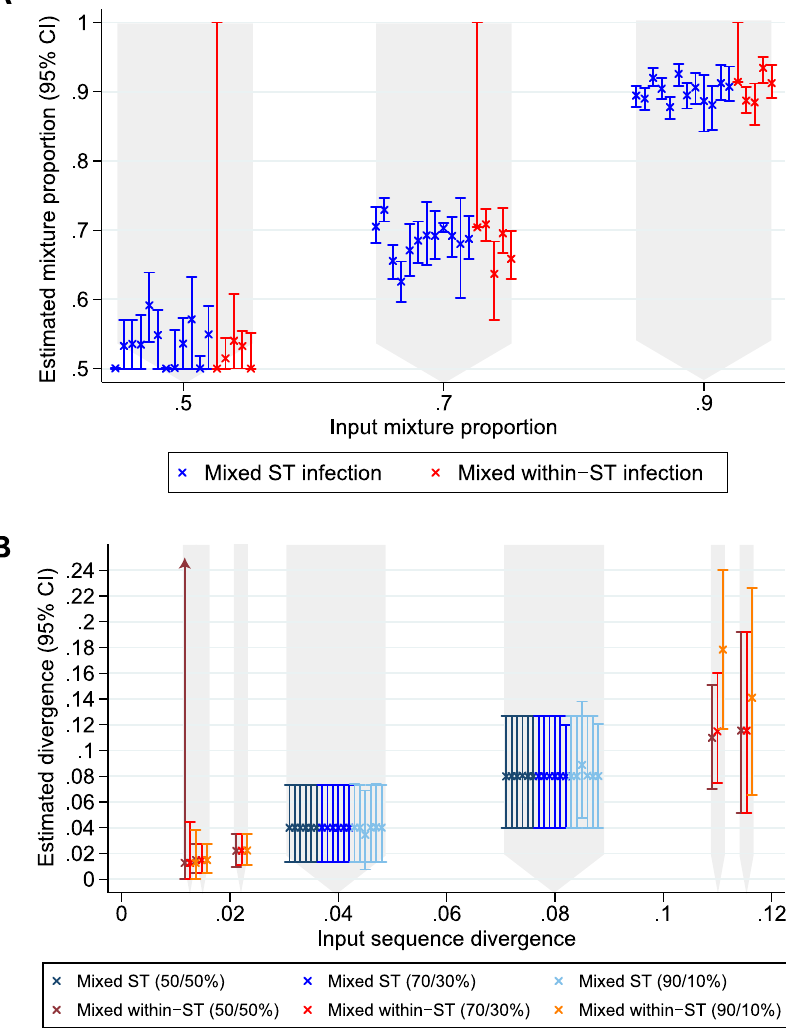
Figure 2. Invitro simulated mixed infections. Panel A shows the estimated mixture proportion for 3 input DNA mixture proportions. For ease of visualisation individual data points have different x-axis values, but correspond to the 3 x-axis values as indicated by the grey background. Points obtained from mixes of two differing STs are shown in red, and points from mixing two isolates of the same ST in blue. The large confidence intervals for the leftmost of each red group of samples is a sample with only a single variant site between the two input sequences, which when excluded in bootstrap sampling makes the sample appear unmixed. Panel B shows the estimated divergence between sequences for differing input divergence and mixture proportions. The leftmost group of 3 points represent a sample with a single variant site, which when excluded in bootstrap sampling makes the sample appear unmixed and estimates of d unstable between 0 and 1.